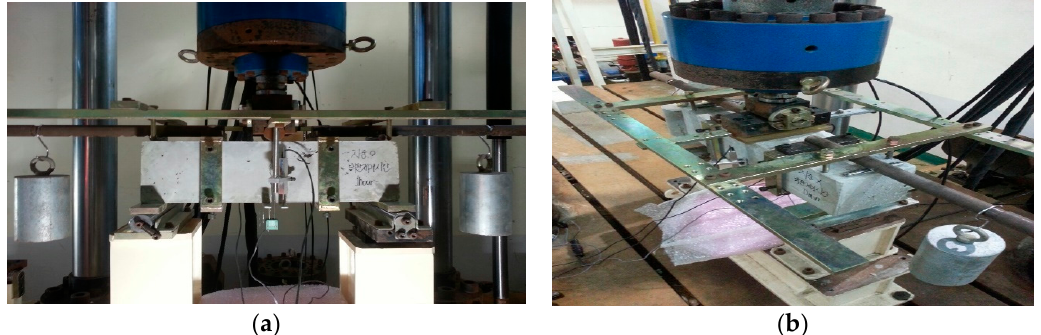
Figure 5. Measured and total works of fracture energy.